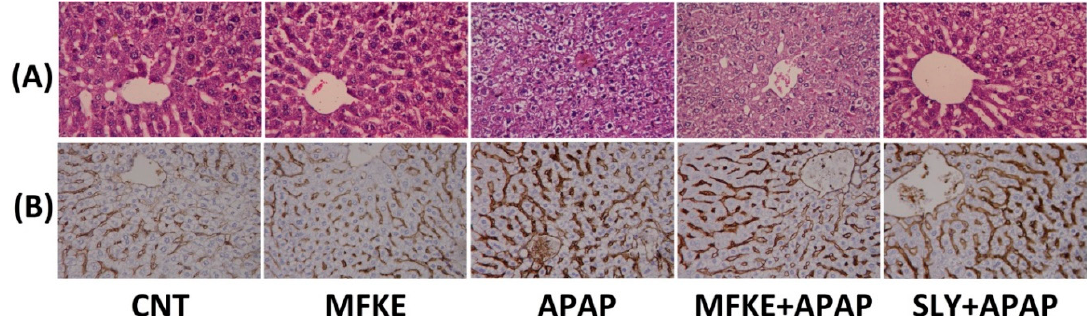
Figure 7. Effects of MFKE on liver pathology and α -SMA in rats treated with APAP-induced liver toxicity. ( A ): H&E stained photomicrographs of liver, and ( B ): Photomicrographs of α -SMA immunoreactivity in liver. Original magnification ×40.